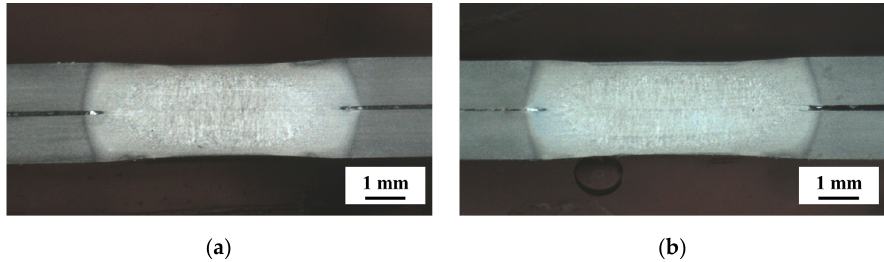
Figure 2. Cross section images of welded specimen using different electrode face diameters ( a ) 8 mm, ( b ) 10 mm. Table 4. Effect of welding conditions on specimen properties: Nugget size, tensile shear strength, and failure mode.